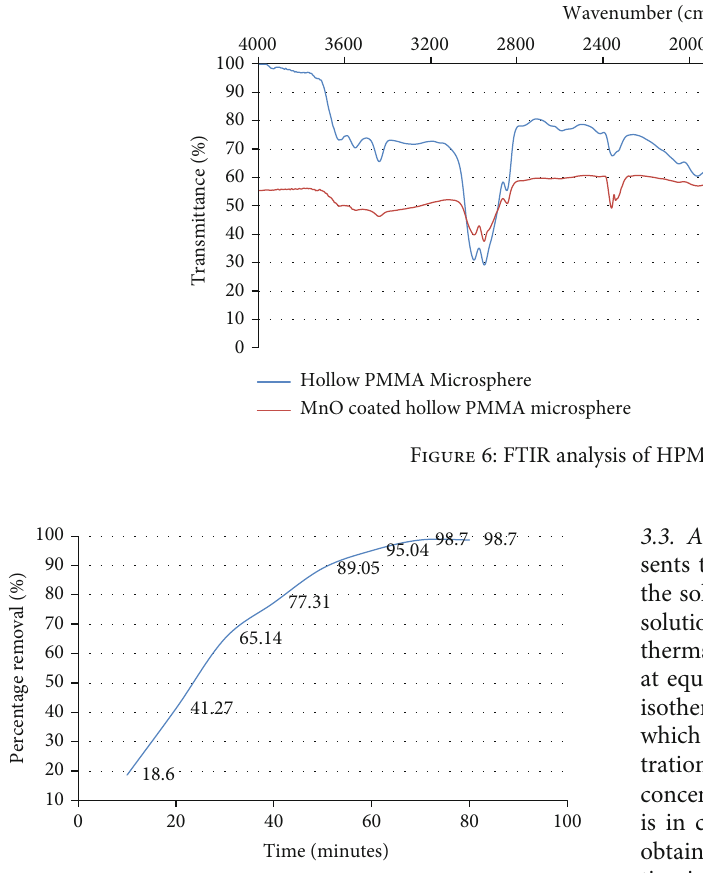
Figure 7: E ff ect of contact time of Mn(II) on %